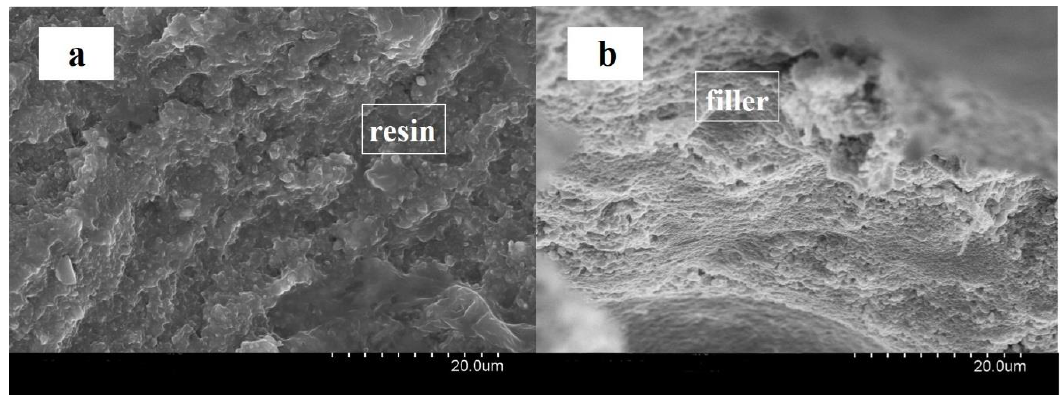
Figure 6. Flexural strength and fracture energy of composite resins with different POSS additions.